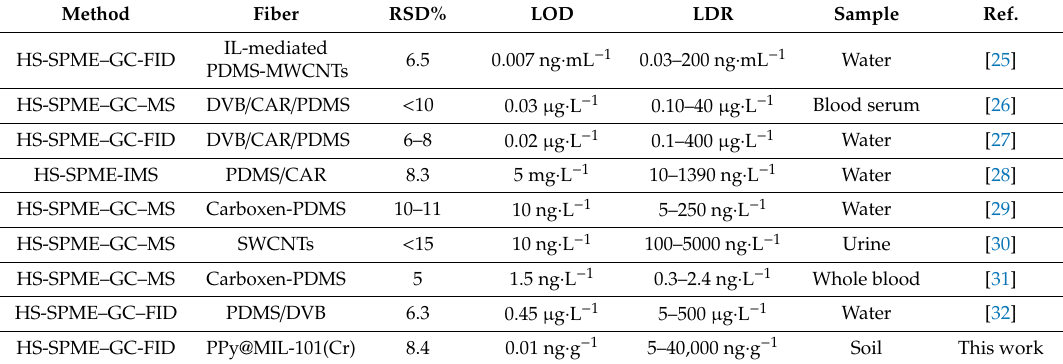
Table 1. Comparison of the developed HS-SPME–GC-FID method with some of the important reported procedures, for the extraction and determination of MTBE.